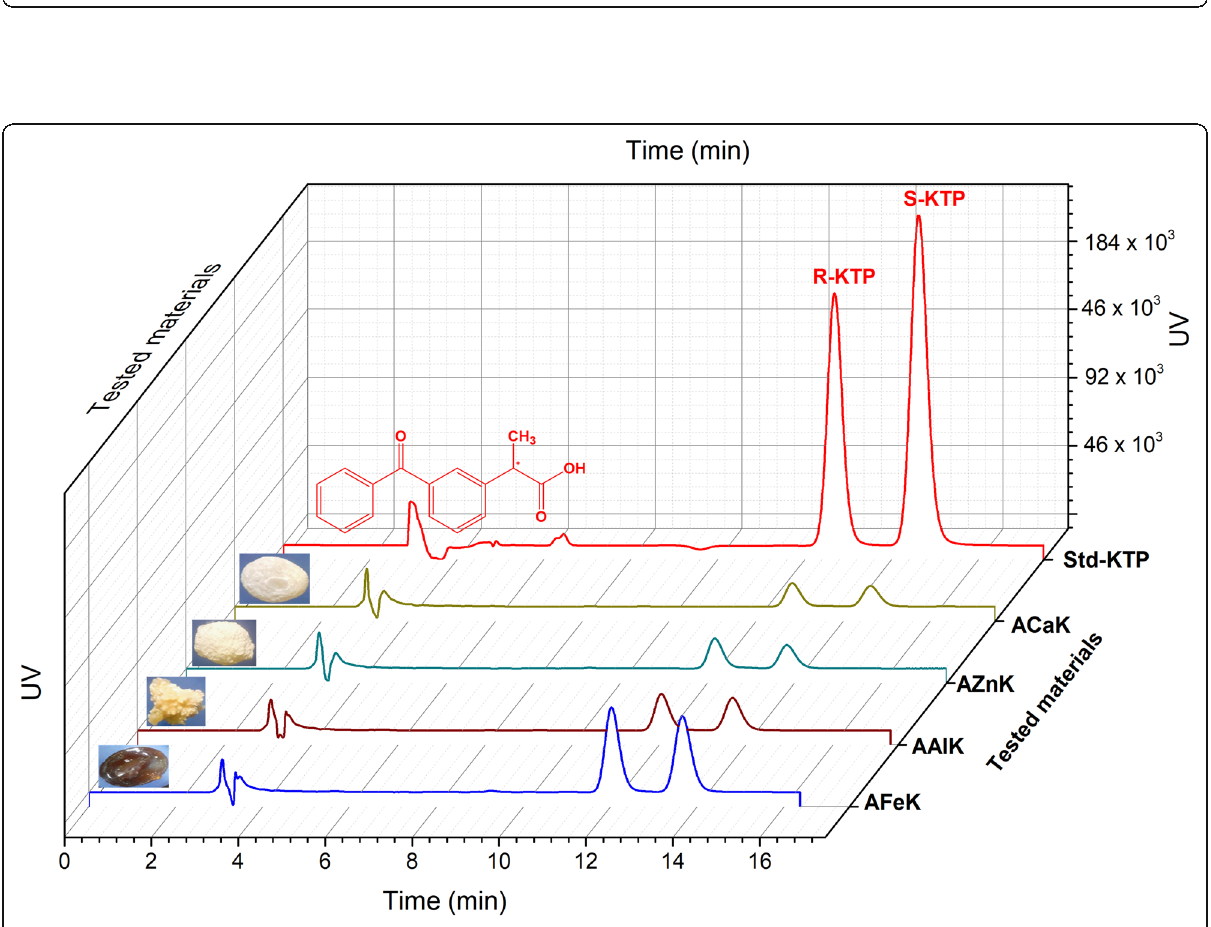
Fig. 5 Cumulative released KTP percentage curves for consecutive congealed beads (ABaCaK, ABaFeK, ABaAlK, ABaZnK), 10-day experiment